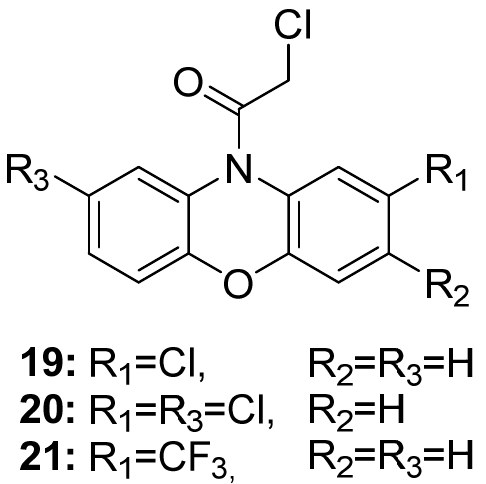
Figure 13. Compounds that have exhibited some interesting potential to treat L. major